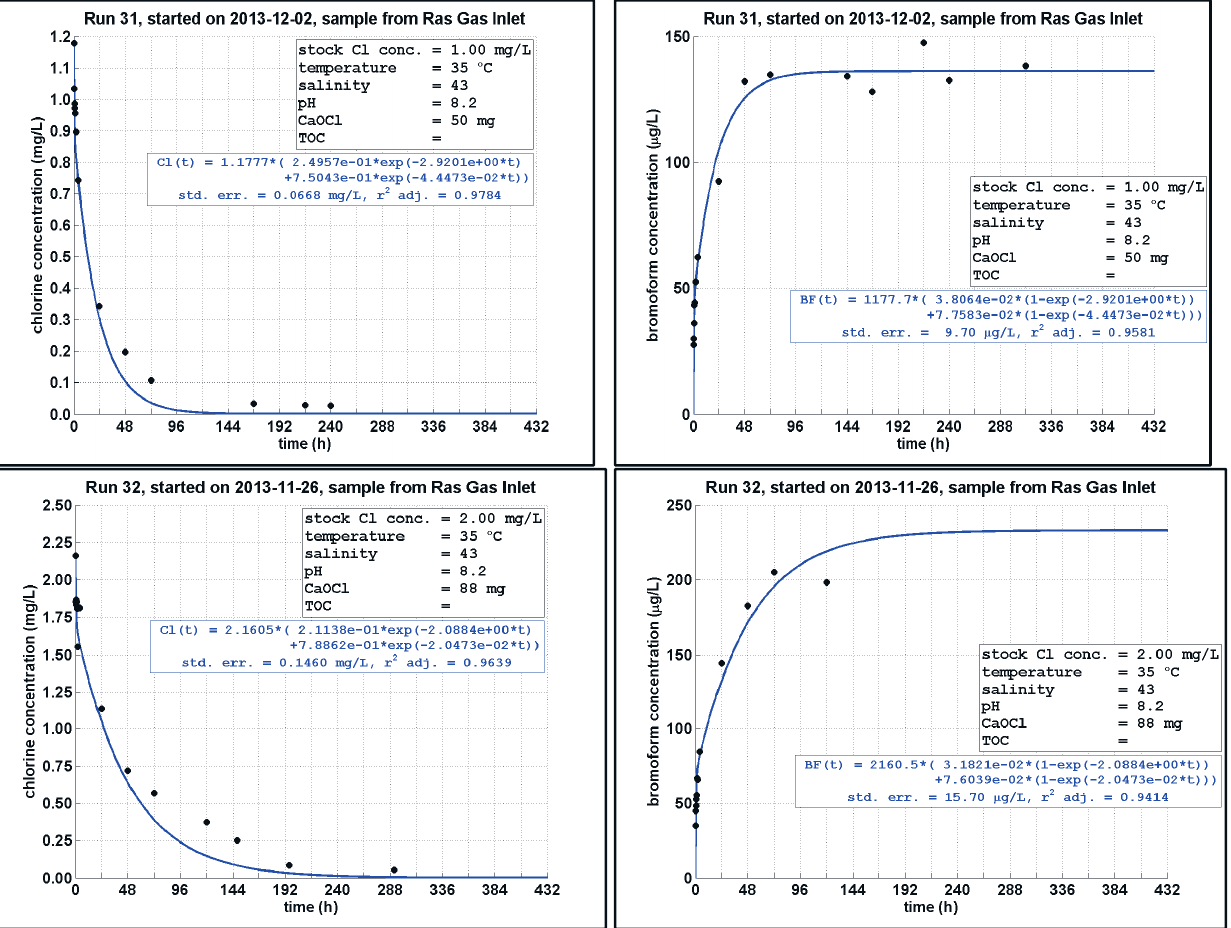
Figure 2. Curve fit results for the effect of initial chlorine concentration on chlorine decay and chlorination by-product (CBP) formation. Insets show run properties and a statistical summary of the curve